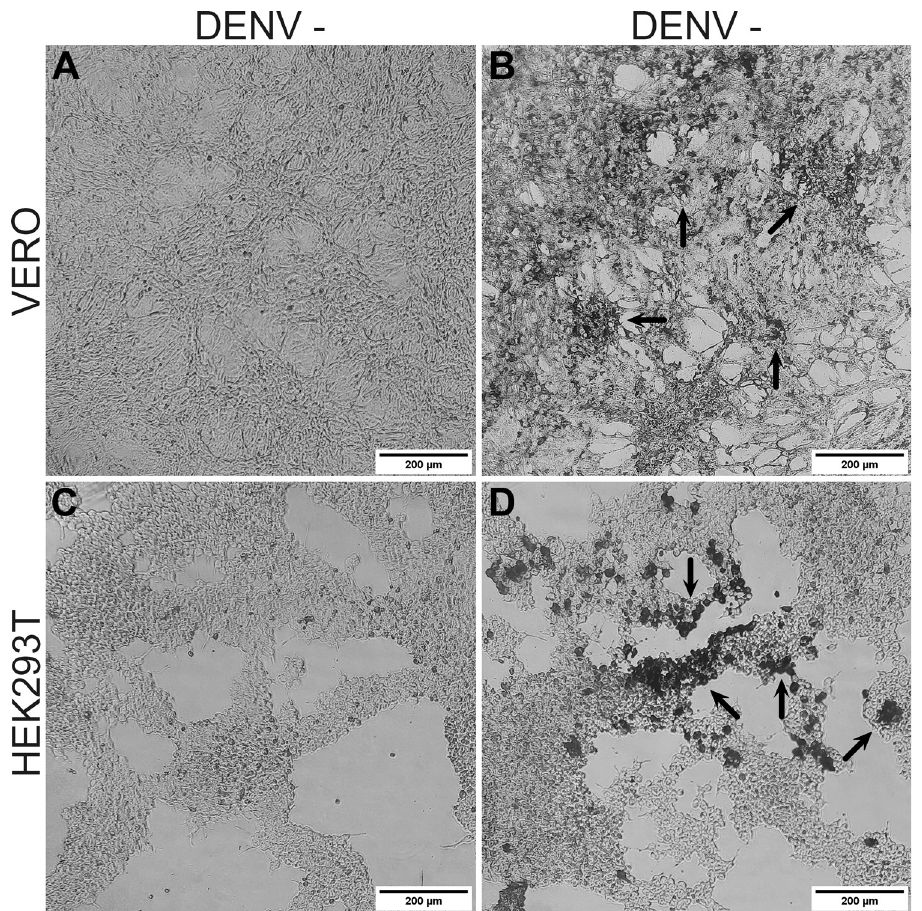
Fig 2. Dengue vaccine infectivity in VERO and HEK293T cells by immunocolorimetric assay. VERO and HEK293T cells incubated with dengue vaccine, 10 − 1 vaccine dilution, for 7 days. Control VERO cells (A) and infected VERO cells (B) stained with anti-E DENV-2 mAb. Control HEK293T cells (C) and infected HEK293T cells (D) stained with anti-E DENV-2 mAb. Black arrows indicate viral infection. Representative images obtained under Olympus microscope at 100X magnification. n =